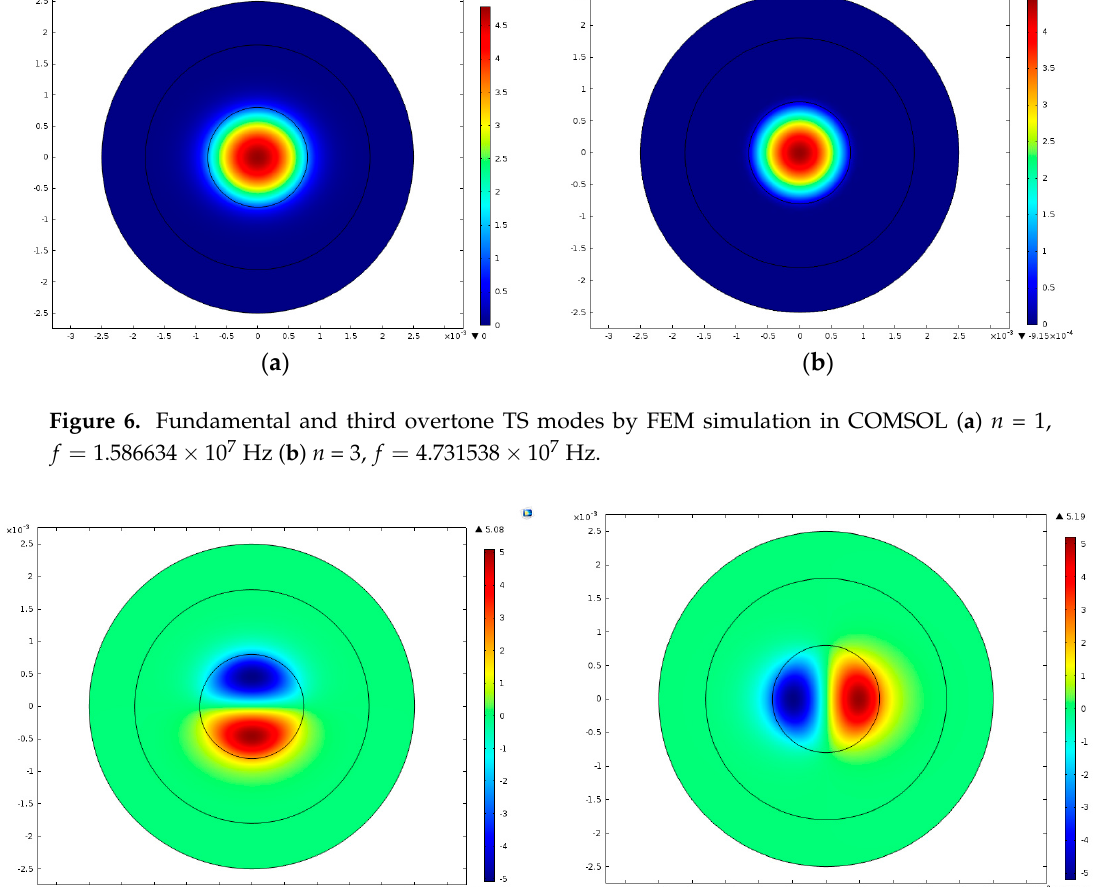
Figure 7. Two spurious modes by FEM simulation in COMSOL ( a ) f = 1.606981 × 10 7 Hz ( b ) f = 1.614231 × 10 7 Hz.